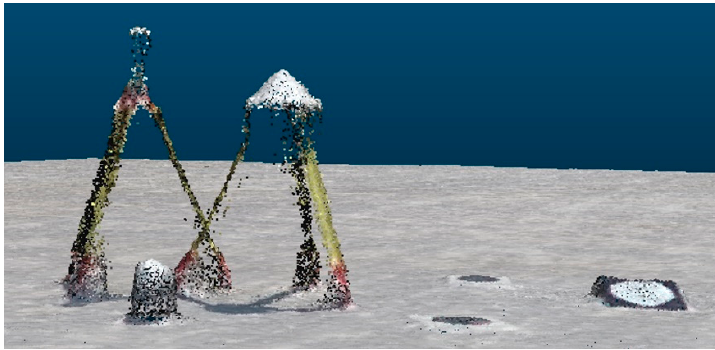
Figure 12. Segment taken from a dense point cloud, created from a UAV40 photogrammetric block. Table 3. Root mean square error ( RMSE ) on GCPs and check points after the georeferencing of the photogrammetric image blocks. The RMSE is given in cm.